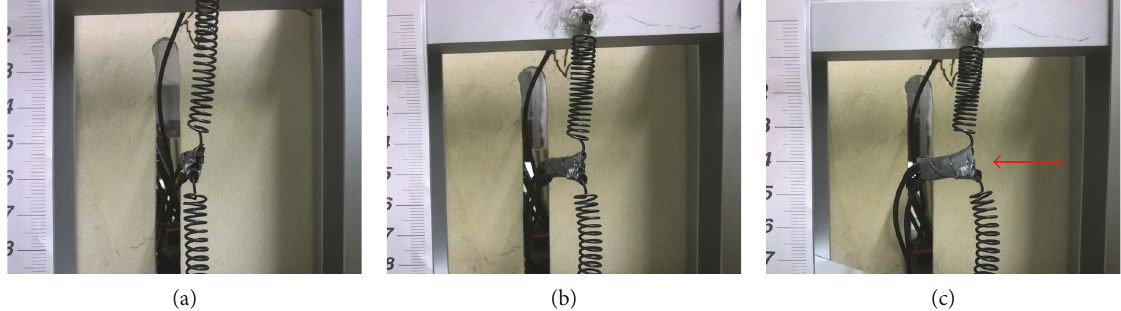
Figure 10: Test I: twisting e ff ect, one spring only stimulated: (a) initial con fi guration; (b) the spring is driven and it starts rotating while lifting the weight; (c) at a visual inspection, the perversion in its fi nal position has experienced a rotation of about 80 ° , as indicated by the red Table 4: Experimental load-displacement data. Applied weight (g)